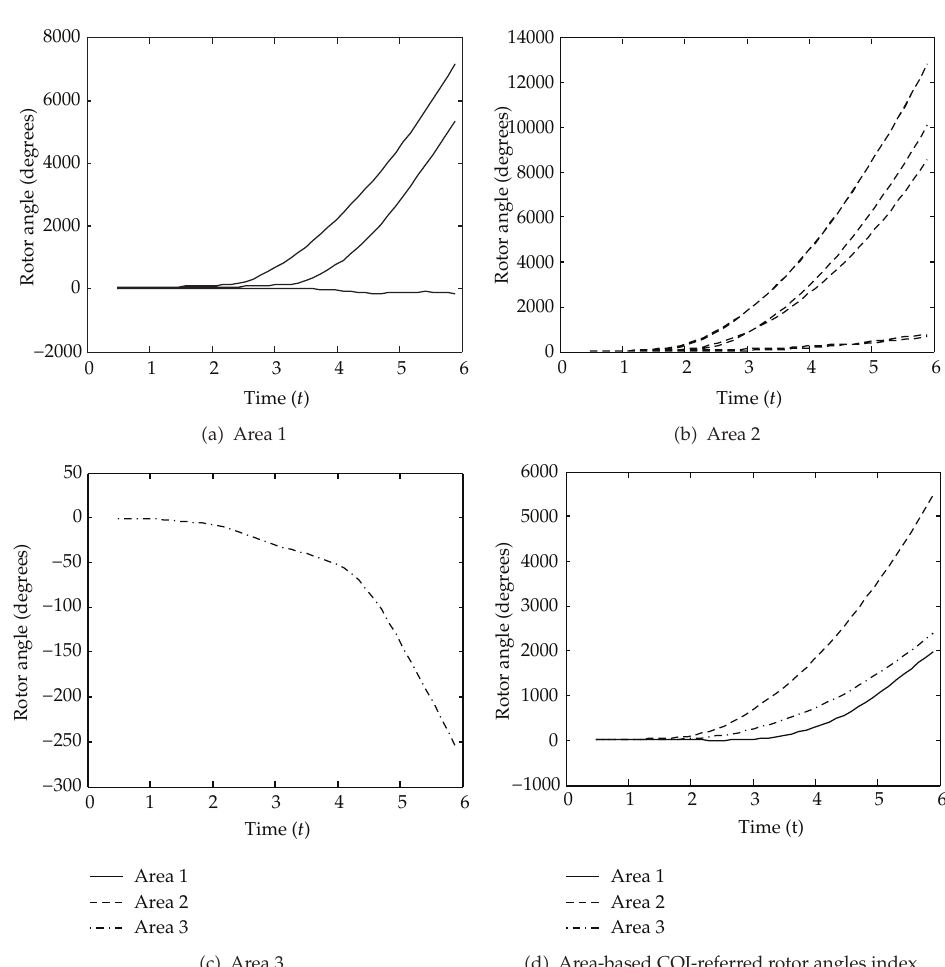
Figure 5: Case 3: the system becomes unstable due to a fault at Line 9 (cid:5) Area 2 (cid:6)